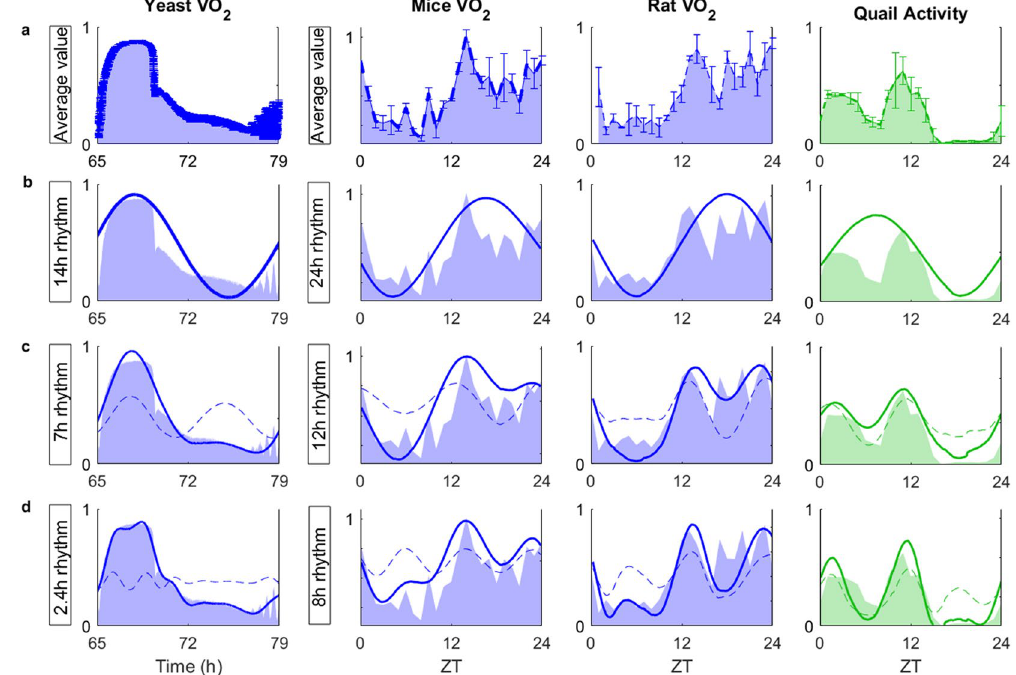
Figure 6. Contribution of circadian and ultradian rhythms to the temporal dynamics of O 2 consumption (VO 2 ) in yeast, mice and rat, along with locomotor activity in quail. Columns indicate animal model, and rows the following from top to bottom: ( a ) time series data is presented as the average of three periods (mean ± SEM) for a time interval of 0.2 min in yeast and 1 h in vertebrates. The colored area under the curve is maintained for comparison; ( b ) representation of the main (solid line) 14 h rhythm in yeast and 24 h circadian rhythm for vertebrates, according to Wavelet Synchrosqueezing (see Figs. 1, 3, S6, S4); ( c , d ) the 7 h and 2.4 h in yeast and 12 h and 8 h rhythms (dotted lines) determined with Wavelet Synchrosqueezing and shown consecutively to the circadian rhythm (solid line). UR, ultradian rhythm; ZT, zeitgeber